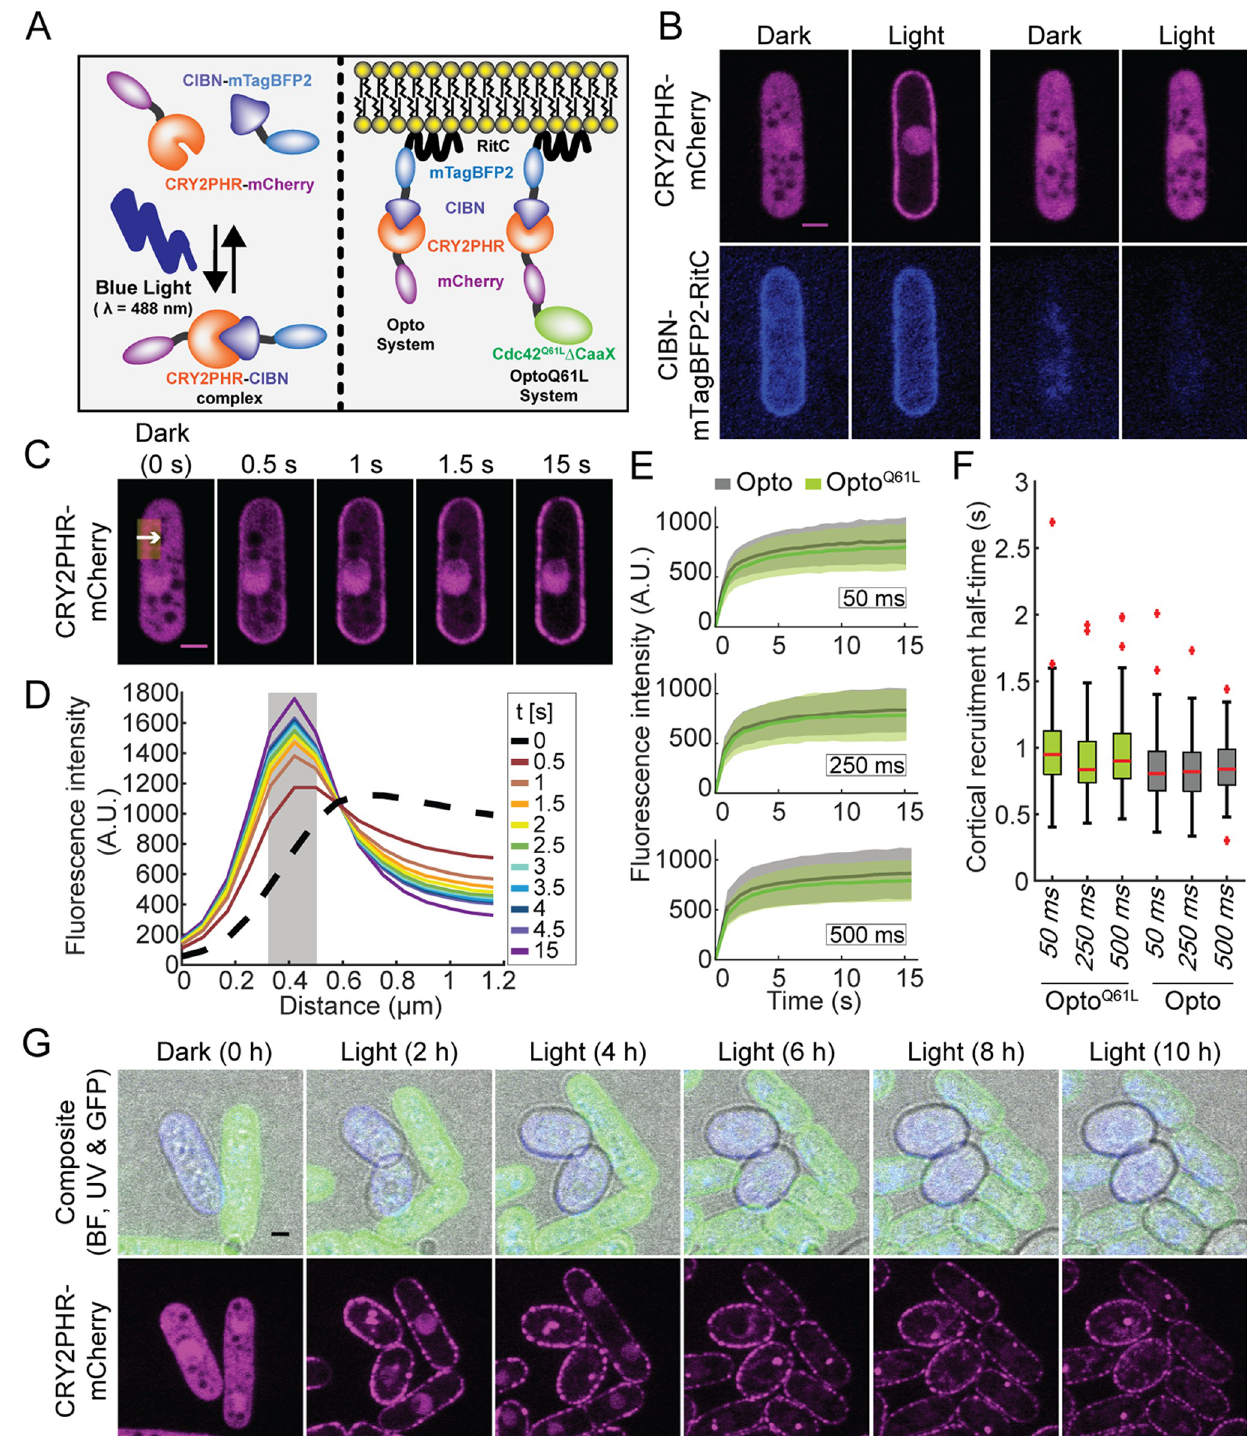
Fig 2. Acute cortical recruitment of protein by optogenetics. (A) Principle of the blue light–dependent CRY2PHR-CIBN complex formation (left) and configuration of heterologous synthetic proteins implemented in S . pombe (right). (B) Blue light–and CIBN-dependent cortical recruitment of CRY2PHR- mCherry. Note that mixtures of sample and control cells were used for this and all optogenetic experiments (see S3 Fig and Methods). The left panels center on a cell expressing both CIBN and CRY2PHR. The right panels center on a cell expressing only CRY2PHR. (C) Plasma-membrane recruitment of the Opto system in response to periodic 50-ms blue-light ( λ = 488 nm, 30 cycles) stimulation. The white arrow within the yellow ROI ( � 1.25 μ m by 3 μ m) indicates the region quantified in (D). (D) Profiles extracted from the ROI highlighted in (C); the gray area indicates the plasma-membrane position, defined as the 3 pixels surrounding the peak fluorescence intensity at the end of the time lapse. These pixel values were averaged and displayed over time to display the plasma-membrane recruitment dynamics shown in (E). (E) Plasma-membrane recruitment dynamics (extracted from the signal in the gray area in (C)) of Opto (gray) and Opto Q61L (green) in response to periodic 50 ms (top), 250 ms (middle), and 500 ms (bottom) blue light ( λ = 488 nm) pulses ( N = 3, n = 30